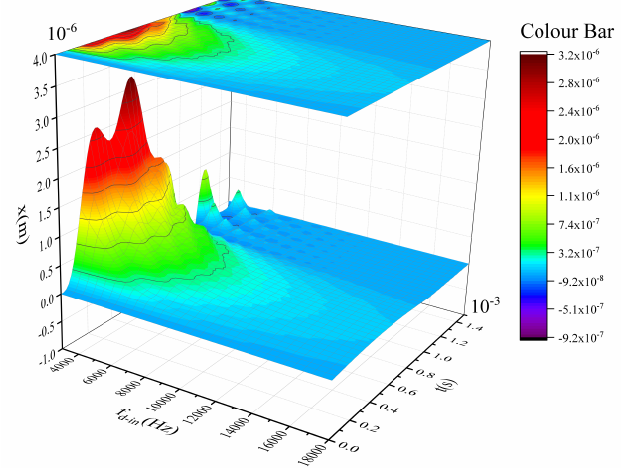
Figure 4. The shock response related to the in-phase